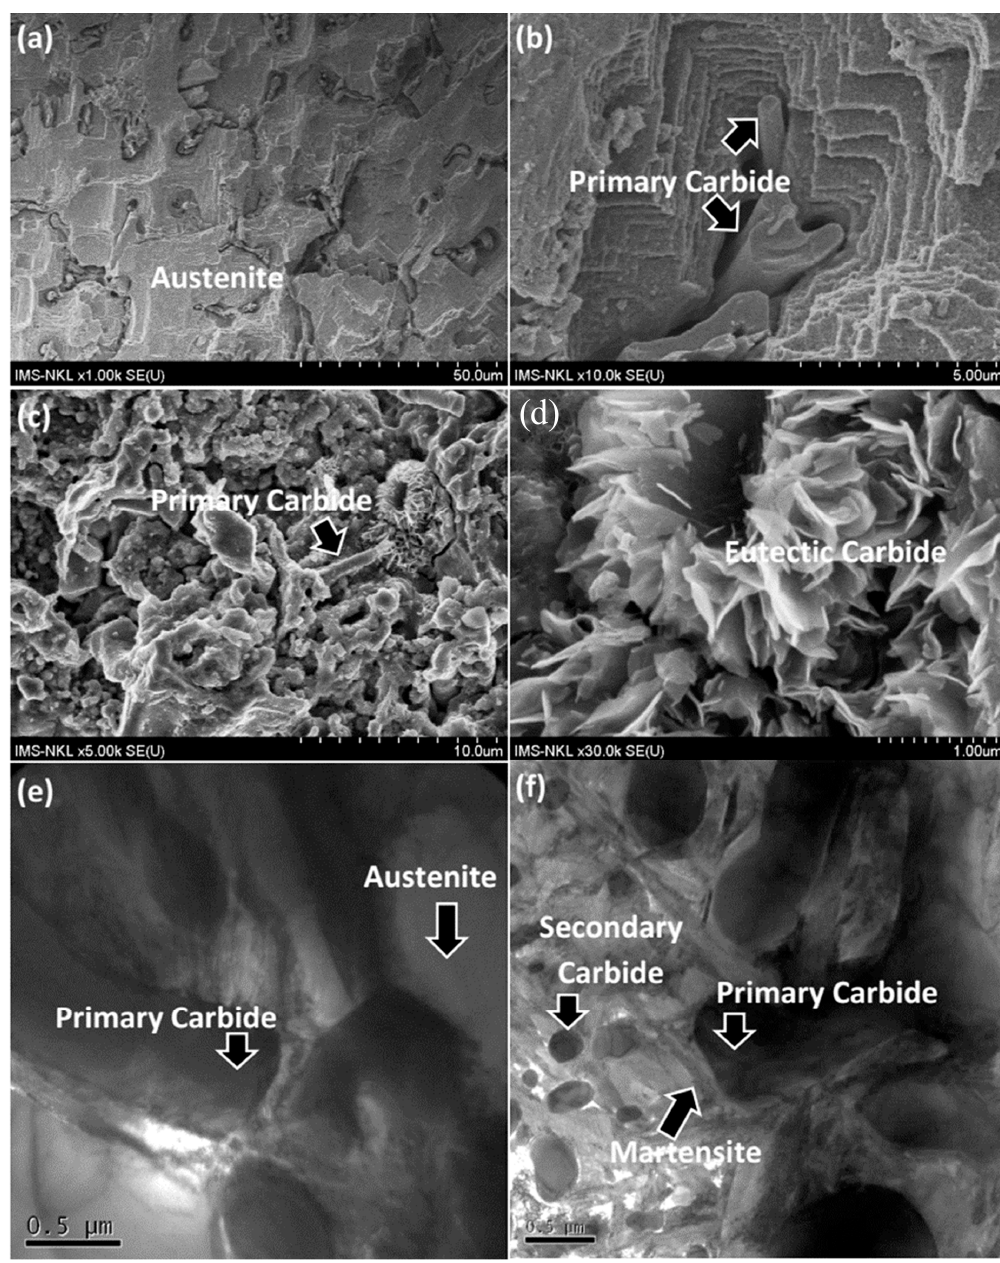
Figure 6. SEM images of ( a , b ) as-cast sample; ( c , d ) HT sample and ( e ) bright field TEM image for an as-cast sample and ( f ) bright field TEM image for HT sample.